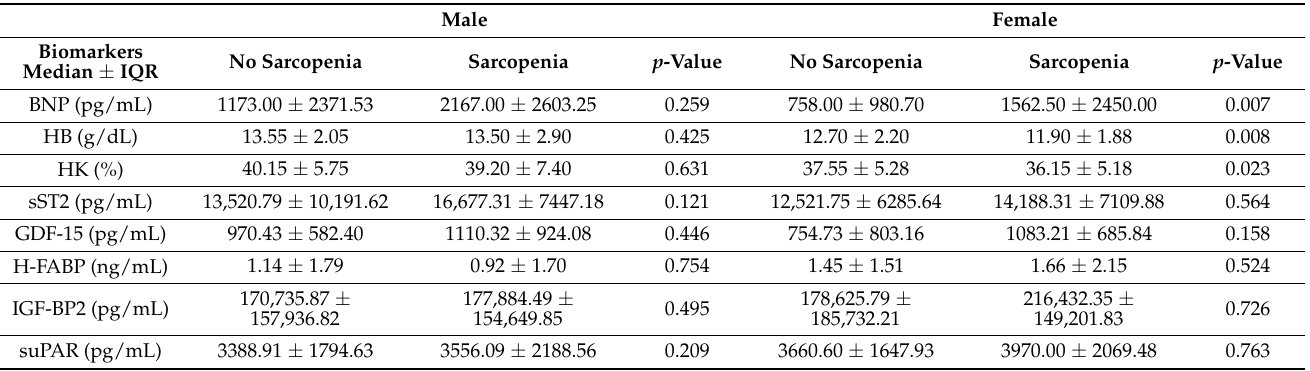
Table 3. Relevant cardiovascular biomarkers of sarcopenic and non-sarcopenic patients according to gender.